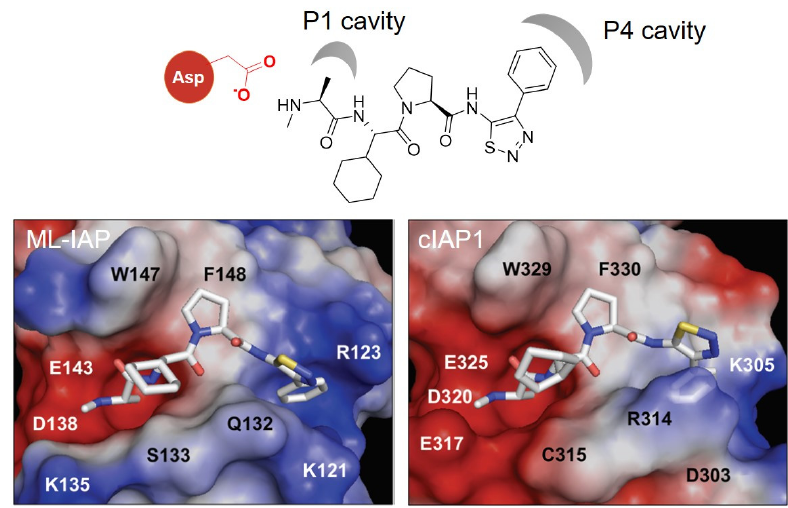
Figure 9. Chemical structure of GDC-0152 and its key binding modes to ML-IAP ( left ) and cIAP1 ( right ). Reprinted with permission from ref. [53] (Copyright 2012 American Chemical Society).